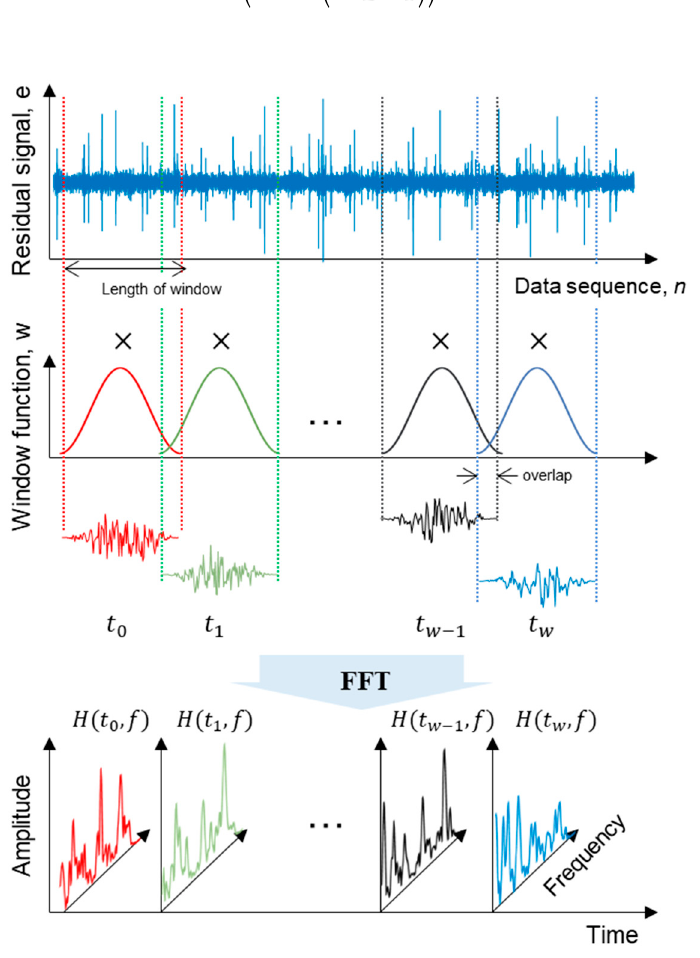
Figure 8. Concept of STFT.